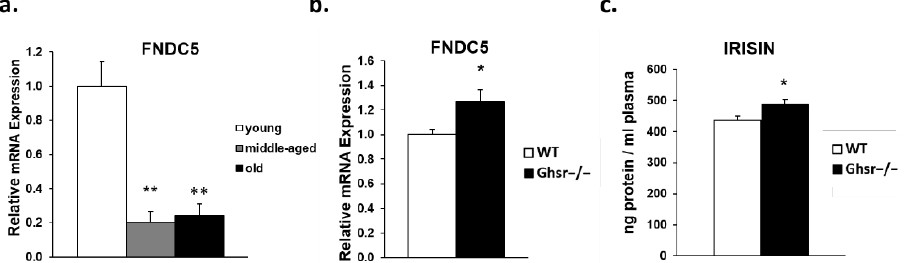
Figure 5. FNDC5 expression in gastrocnemius muscle and plasma irisin in the circulation. ( a ) FNDC5 mRNA expression in young (4–5 m), middle-aged (12–14 m) and old (18–26 m) WT mice ( n = 6). ( b ) FNDC5 mRNA expression in gastrocnemius muscle of old WT (open bar) and Ghsr − / − (filled bar) mice. ( c ) Plasma irisin levels in old WT (open bar) and Ghsr − / − (filled bar) mice. 18s and β -actin house- keeping genes were used as internal controls in qPCR analysis. One-way ANOVA was performed in (a) and Student’s t -tests were performed for (b) and (d). Data are presented as means ± standard error. * p < 0.05, ** p < 0.001, middle-aged or old mice vs. young mice, or Ghsr − / − . vs. WT.